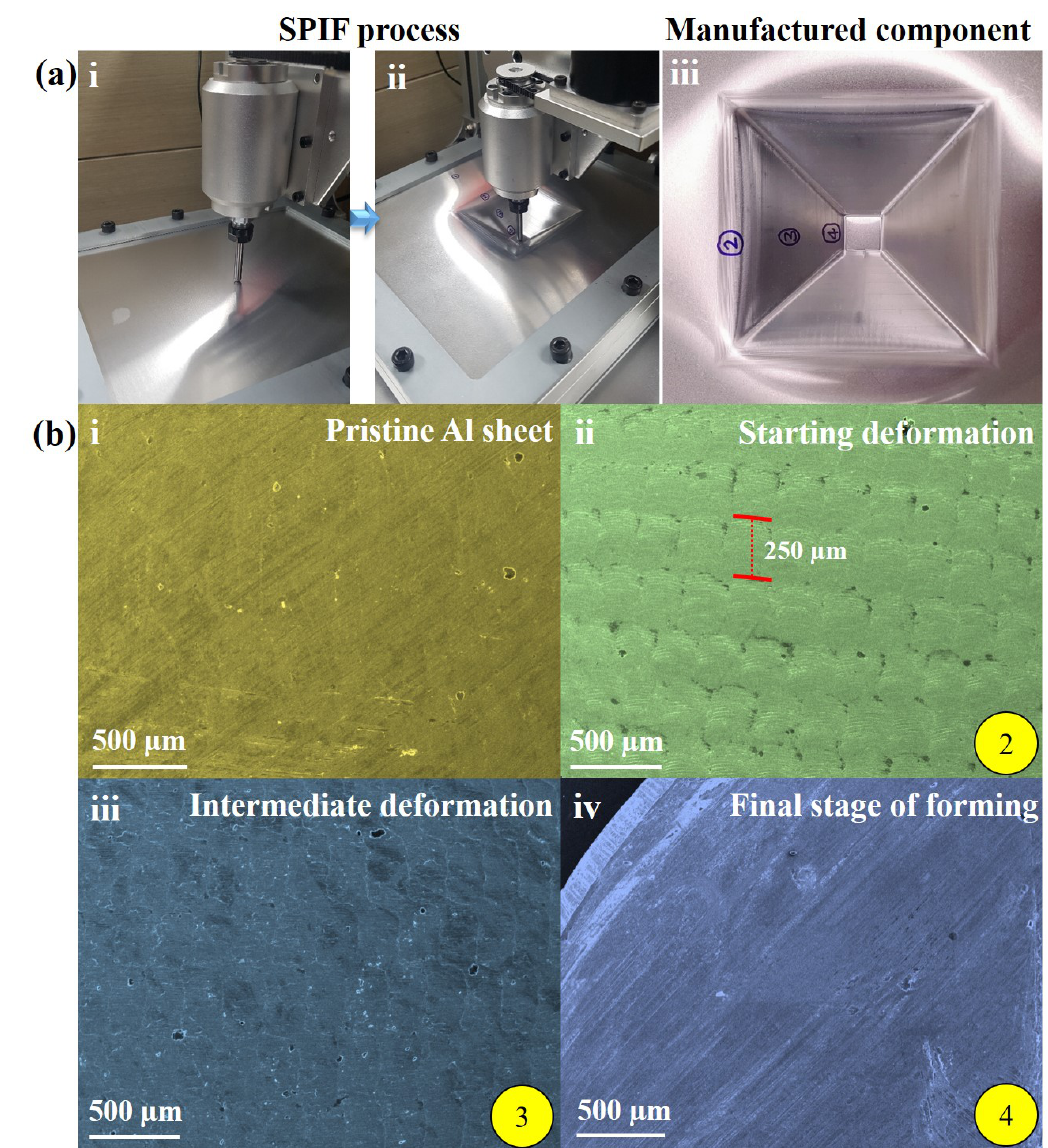
Figure 5. ( a ) SPIF process illustration and final part; ( b ) microstructure of aluminum alloy (AA3003) material at various forming stages, observation by FESEM at 500µm